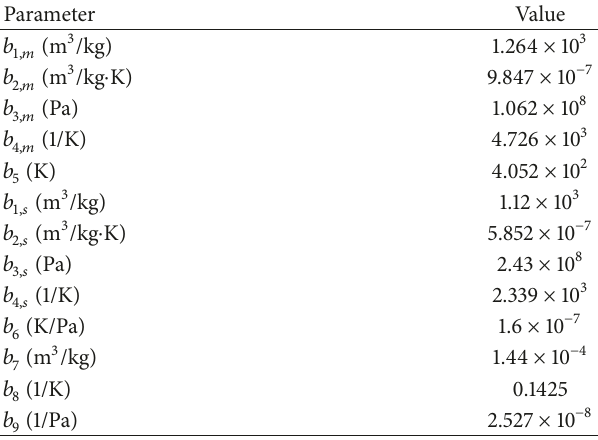
Table 2: Tait state equation parameters of HDPE.